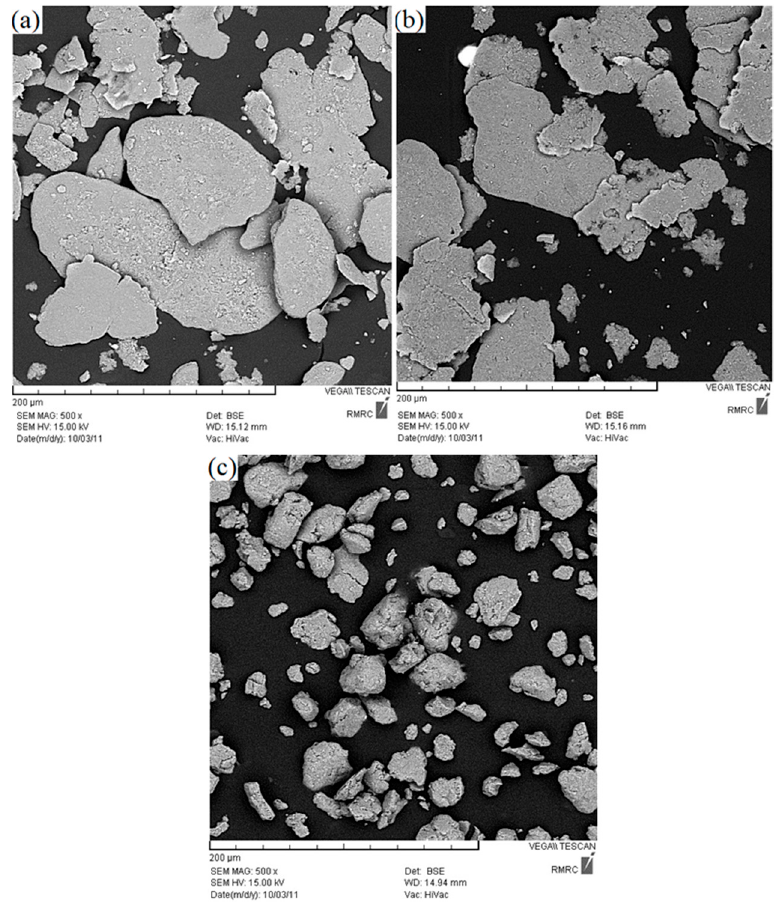
Figure 1. Scanning electron microscope (SEM) images of Al–5 wt %Si powders for different milling durations: ( a ) 5 h, ( b ) 20 h, and ( c ) 50 h.